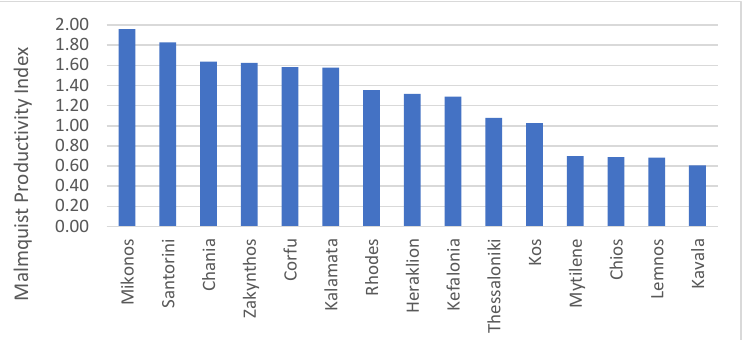
Figure 2. Airports’ productivity changes over the study period.